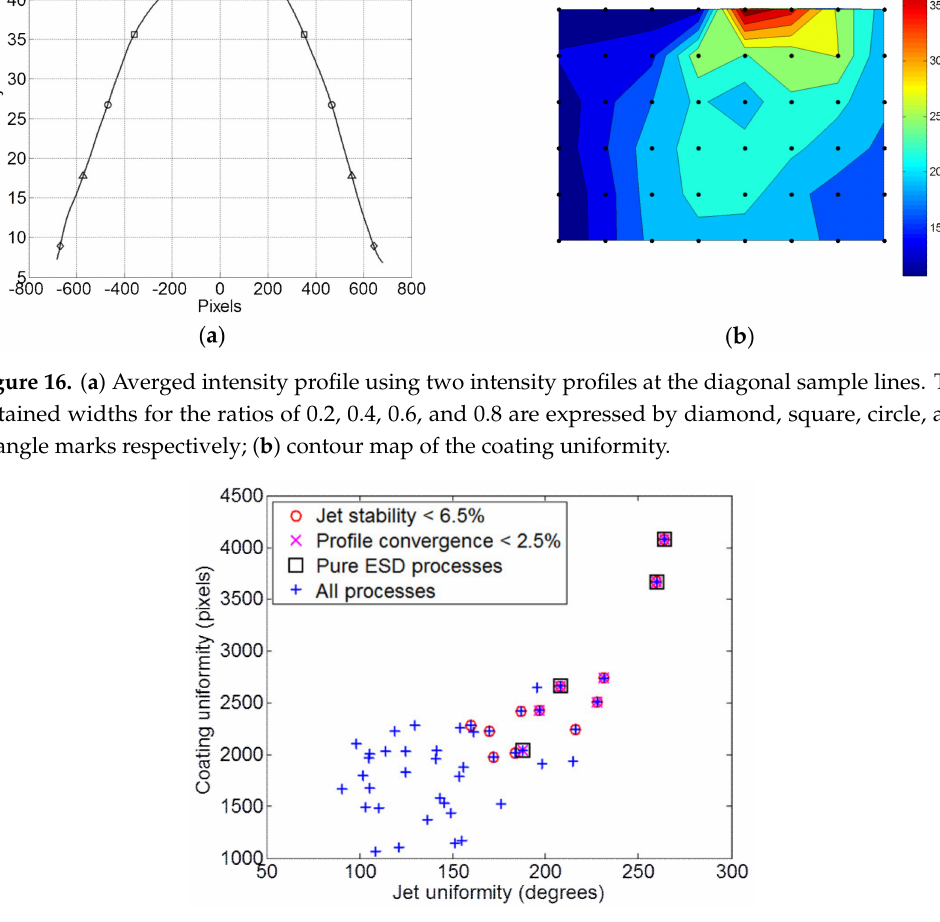
Figure 17. The scatter plot showing the correlation between two uniformities of spray patterns and coated thin films. The correlation coe ffi cient for all process conditions was 0.6859 and the correlation coe ffi cients were enhanced to 0.8588, 0.9285 and 0.9886 by restricting the process conditions as shown in the respective